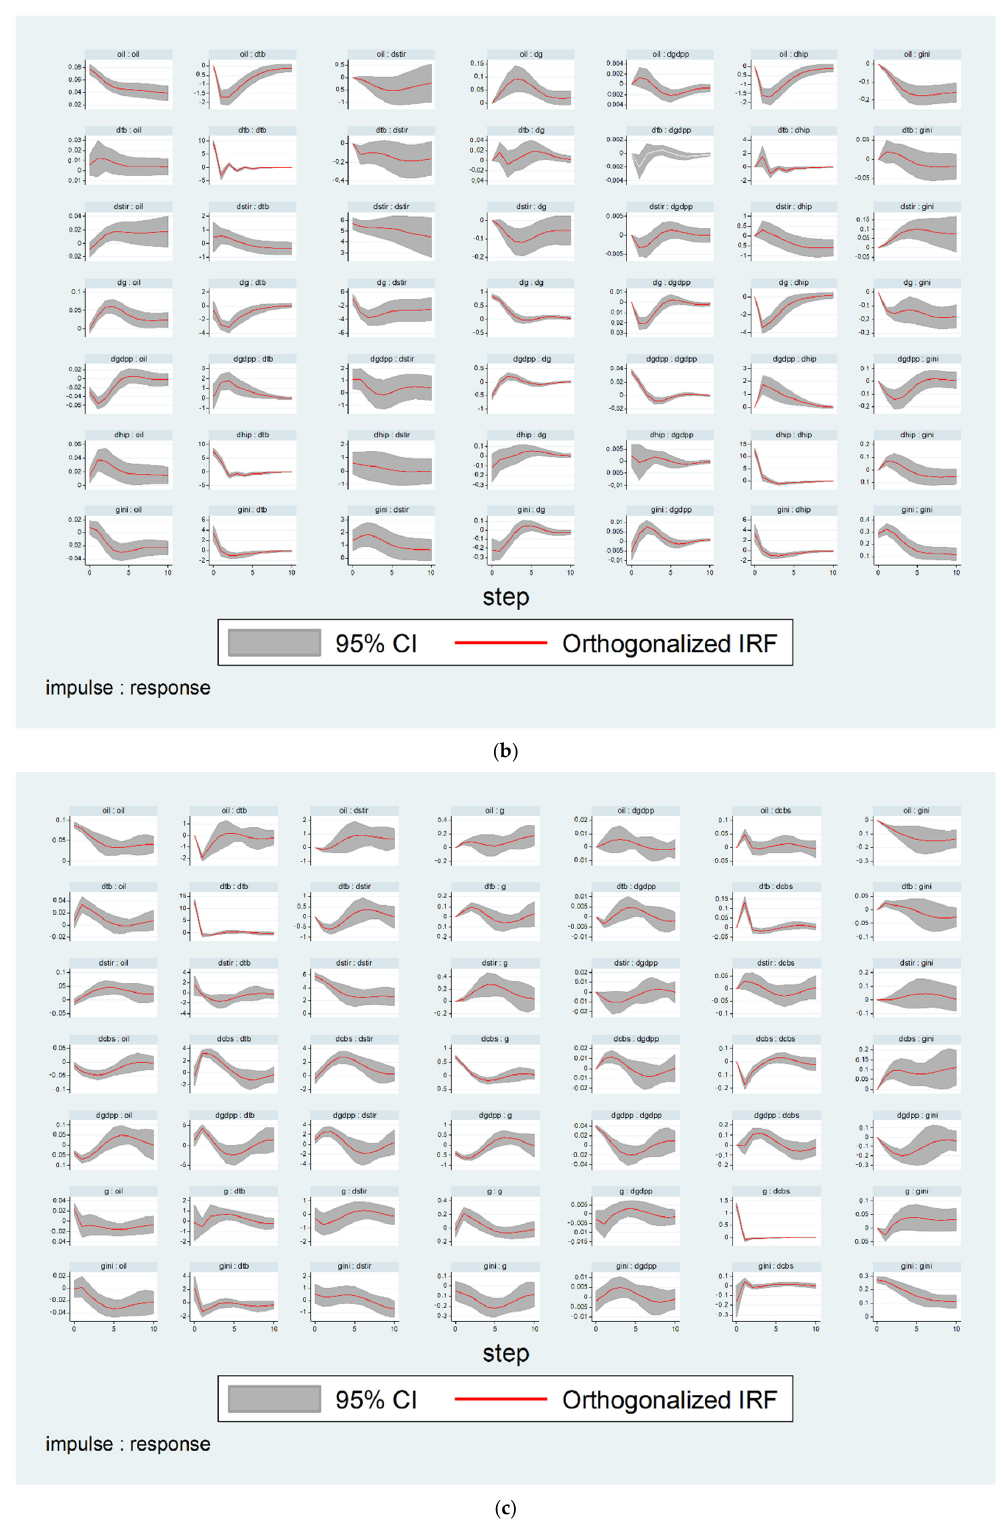
Figure 2. ( a ) Response of inequality on unconventional monetary policy (heterogeneity channel). ( b ) Response of inequality on unconventional monetary policy (portfolio channel). ( c ) Response of inequality on unconventional monetary policy (Income-composition) channel. Note: The shaded areas refer to the 95% confidence band. Moreover, the IRFs present two periods, which are a short run from zero to four years and a long run from five to 10 years. Therefore, the orthogonalised IRF is interpreted as aligned with the short-run and long-run periods, as defined. Source: Author’s illustration based on SWIID (Solt 2020; World Development Indicators